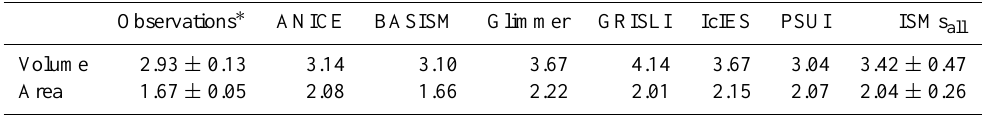
Table 2. Equilibrated ice sheet volume [km 3 × 10 6 ] and area [km 2 × 10 6 ] for Control Phase scenario Control had for individual ice sheet models. ISMs all denotes all-model means.